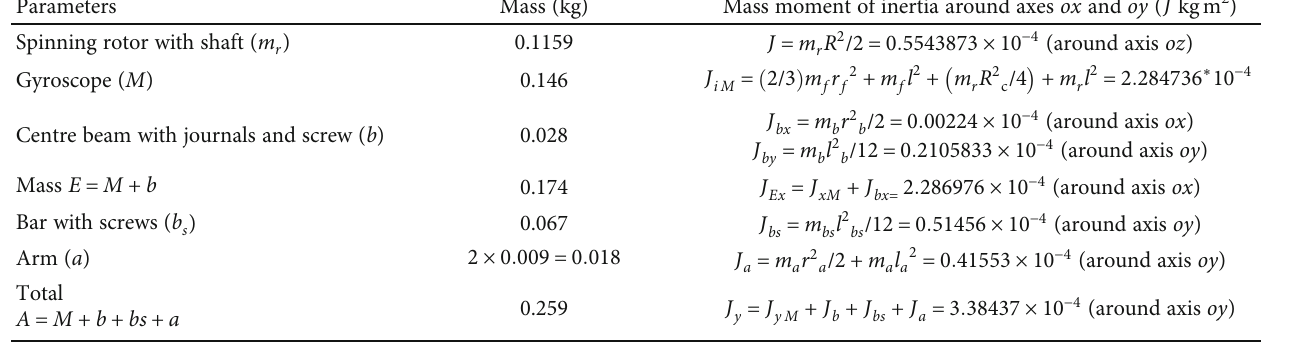
Table 1: Technical data of the test stand with Super Precision Gyroscope, “ Brightfusion Ltd. ” .